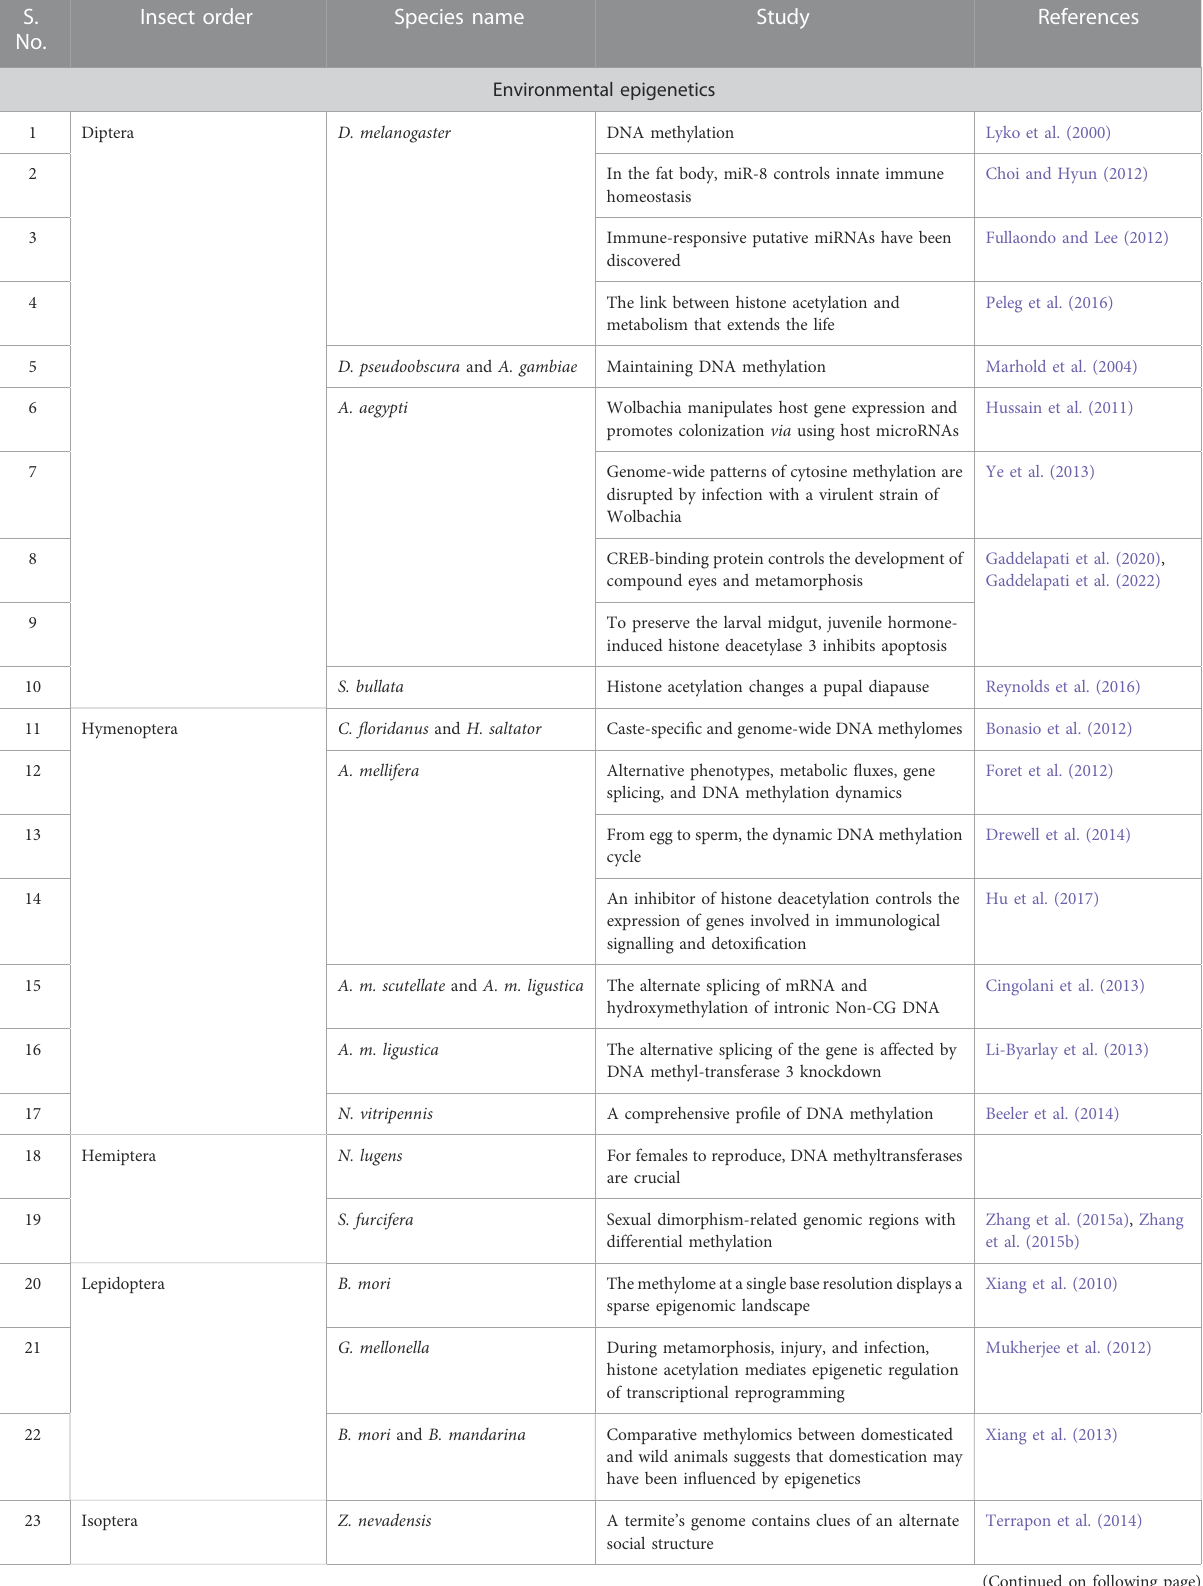
TABLE 1 Epigenetics studies in various insects during the last two decades. S.